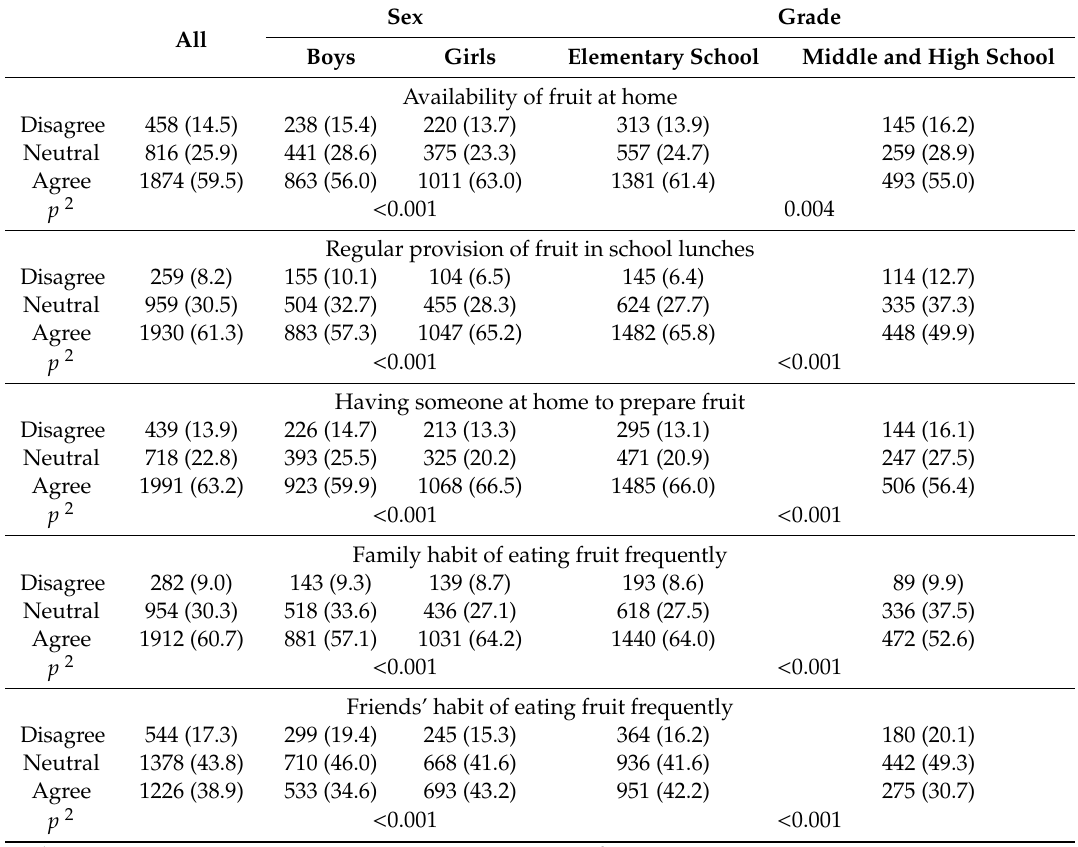
Table 2. Select aspects of participants’ food environments 1